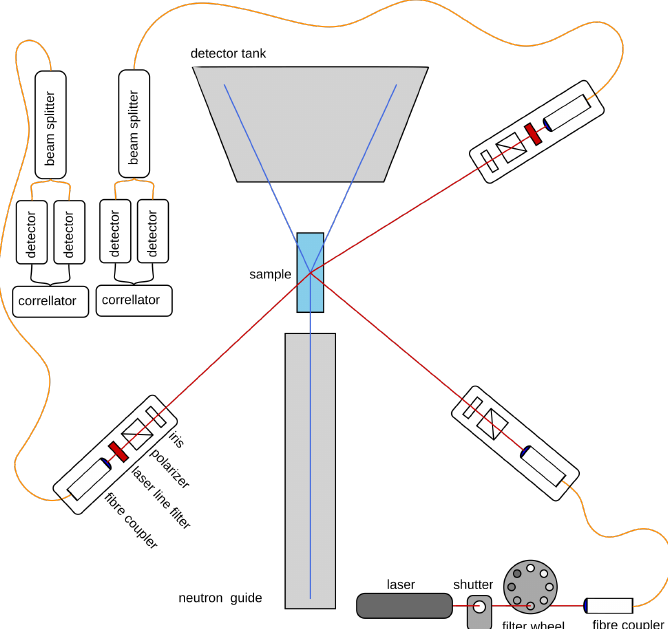
Figure 3. Scheme of the instrument components required for light scattering and the resulting